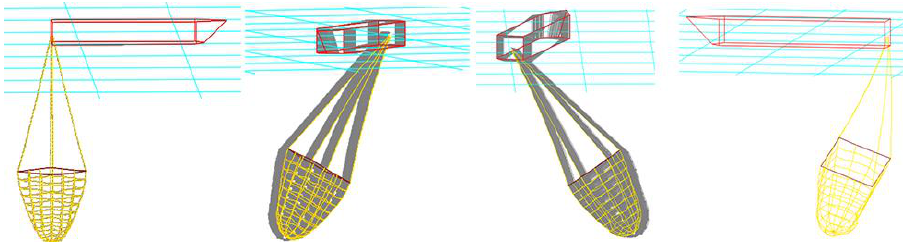
Figure 22. Shape changes of rigid truss trawl rotating towing under fixed turning radius at v = 3 m/s.